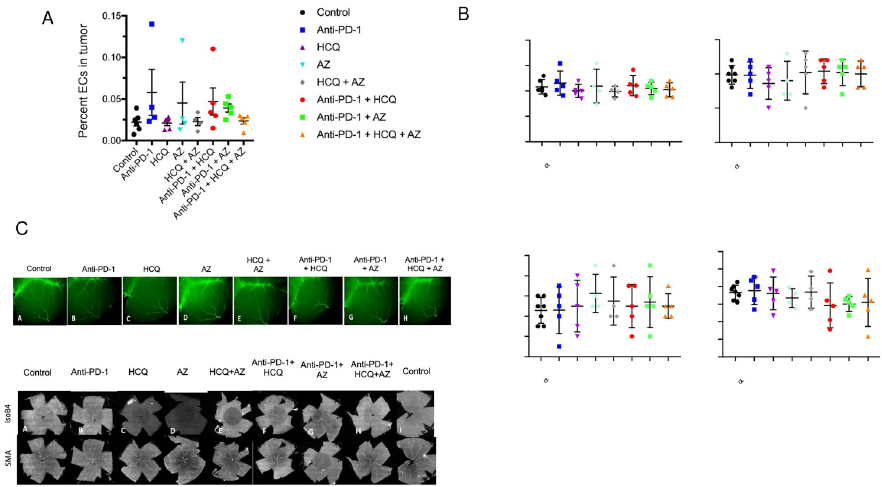
Fig 5. HCQ did not affect the vasculature. Panel A: Frequency of endothelial cells (ECs) relative to viable cells in the tumor. Panel B: Whole mount images of cerebral and retinal vessels. Panel C: Quantification of vessel bifurcation, arterial branches and vessel length in response to different treatments of mice